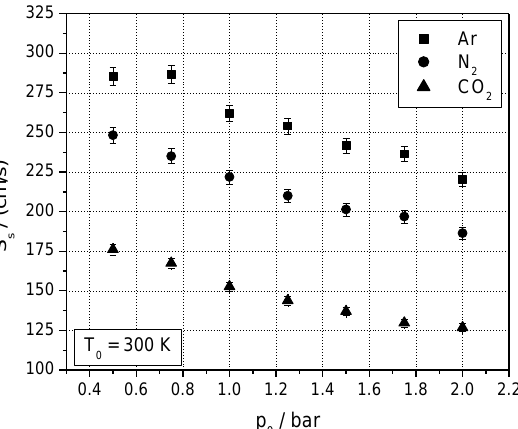
Figure 4. PVs of propane-air – 10% diluent mixtures (Ar, N 2 or CO 2 ) at initial ambient temperature and various initial pressures.